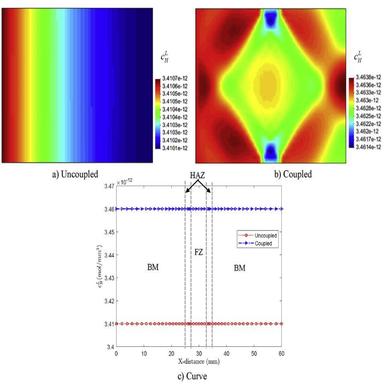
Lattice concentration distribution at t = 125 years: a) without mechanic coupling terms, b) with the actual M-D coupling, c) Comparison curve (middle of the horizontal section of the material).